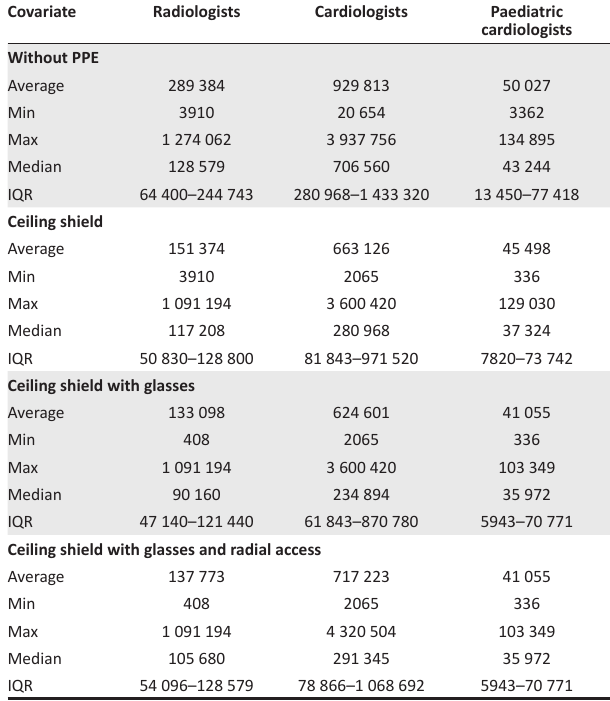
TABLE 4: Posterior sub-capsular and cortical cataracts according to career after excluding participants < 35 years of age and years of occupational exposure to ionising radiation.